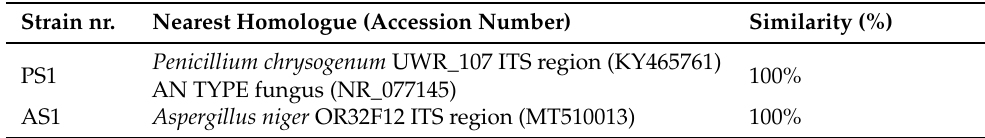
Table 1. Taxonomic classification of the fungal strains. Strain